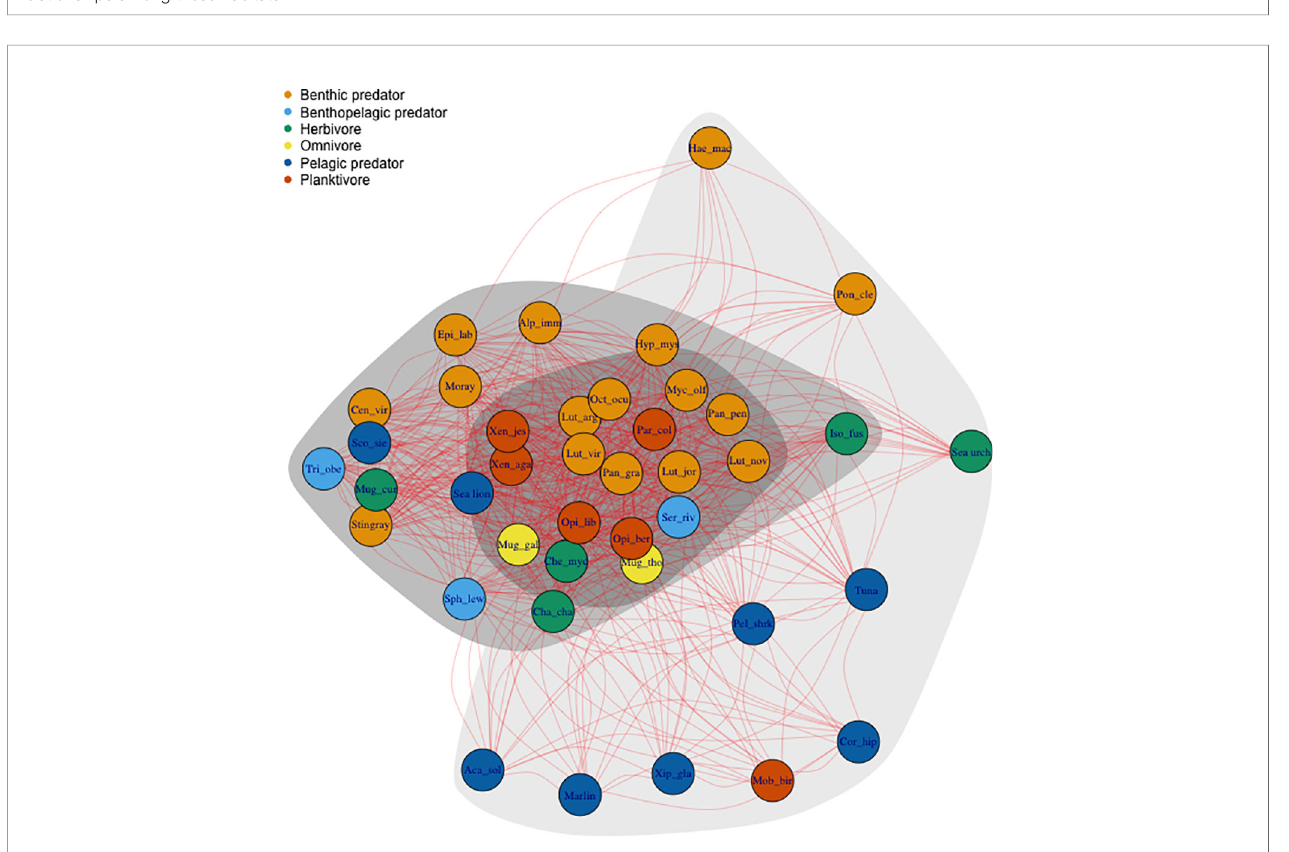
FIGURE 3 | Undirected network representation of species trophic interactions based on shared habitats. Vertices (or nodes) represent species reported by fi shers. Edges (or links) represent shared habitats between species. Clusters group species based on ‘ hub scores ’ estimates during Social Network Analysis and represent cutoff intervals of 1-0.67 (dark grey), 0.66-0.34 (light gray), and 0.33-0 (lightest gray). Species were categorized by feeding type and colored according to legend. Abbreviations for fi shery species were coded using three fi rst letters of genera and species in scienti fi c name (see Table 1 ; Table S8 ). Other abbreviations: Mob_bir, Mobula birostris ; Xip_gla, Xiphius gladius ; Aca_sol, Acanthocybium solandri ; Cor_hip, Coryphaena hippurus ; Pel_shark, other pelagic sharks; Sph_lew, Sphyrna lewini ; Iso_fus, Isostichopus fuscus ; Moray, moray eels; Sea urch, sea urchins; Tri_obe, Triaenodon obesus.